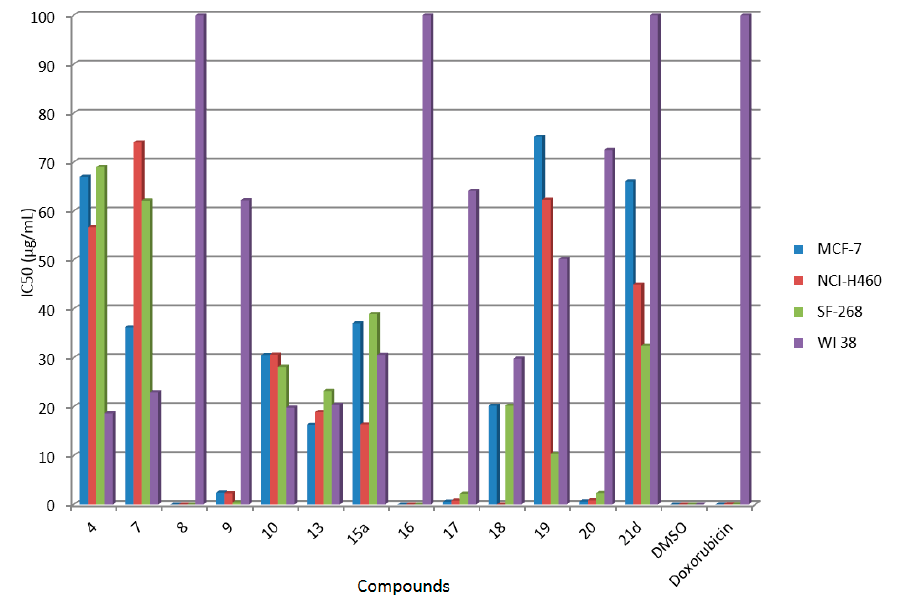
Figure 2. Cytotoxic activity of some newly synthesized compounds against human cancer cell lines and normal cells.